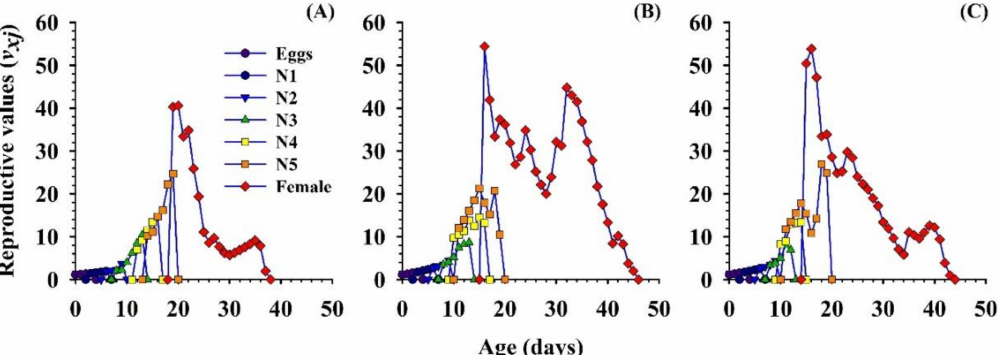
= 1st Instar, N2 = 2nd xj ) of the O. strigicollis ; N1